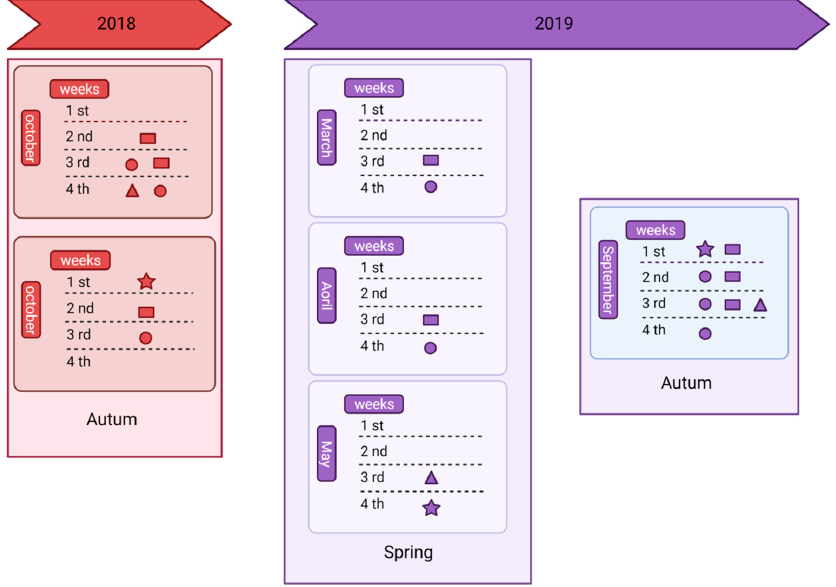
Figure 1. Chronology of the operations performed in the colonies. Rectangle: put clean sanitary bottom. Circle: remove sanitary bottom. Star: treatment against V. destructor with amitraz. Triangle: wax and beebread sampling. Created by Biorender software.